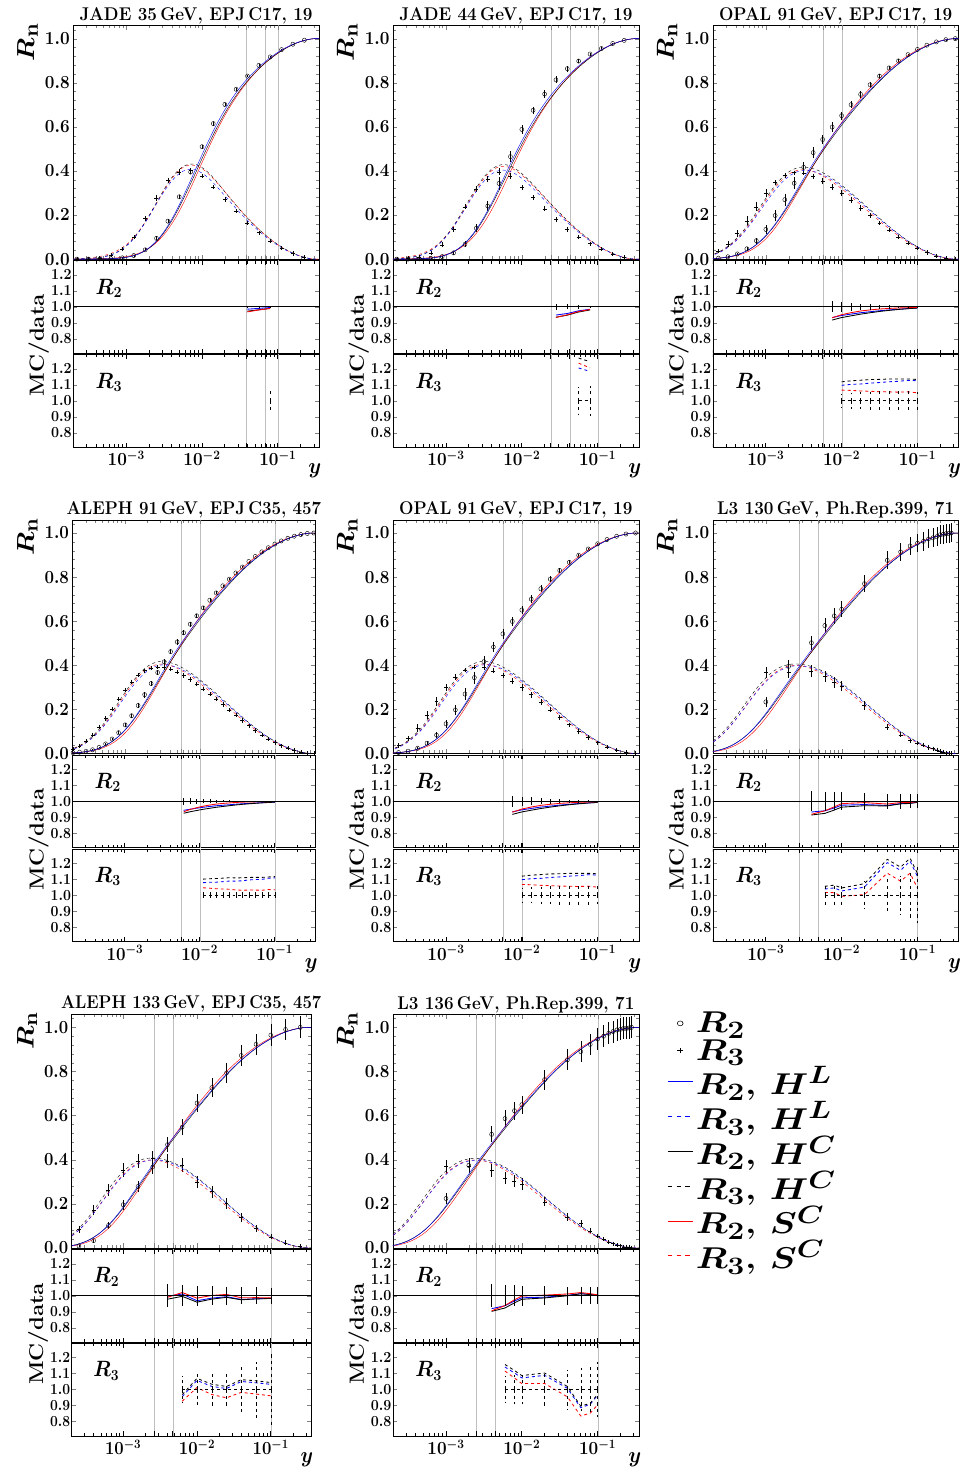
Figure 9 . Predictions obtained with S C , H C and H L MC setups at hadron level.